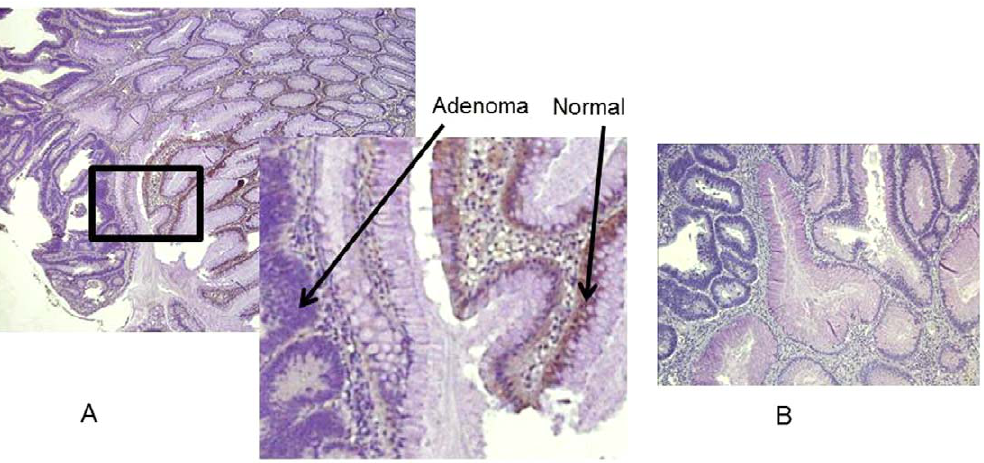
Figure 2. SLC5A8 expression in human colon normal and adenoma. Characteristic cytoplasmic staining of normal colon, and adenoma, was determined by immunohistochemistry, using antibodies against SLC5A8 (A), and negative control without primary antibody (B). Original magnifications, 6 4 magnification, except for enlargements (insets), which are 6 40.